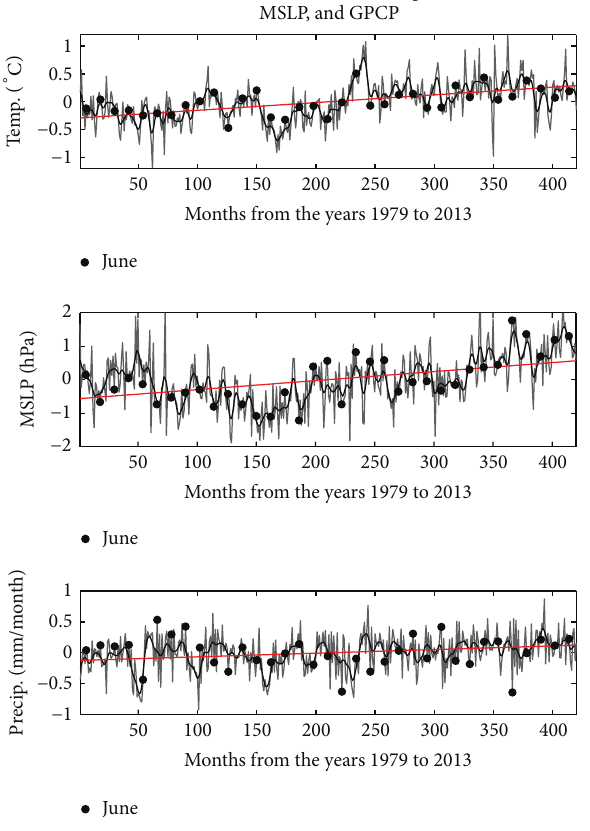
Figure 5: Interannual variation of anomalies.